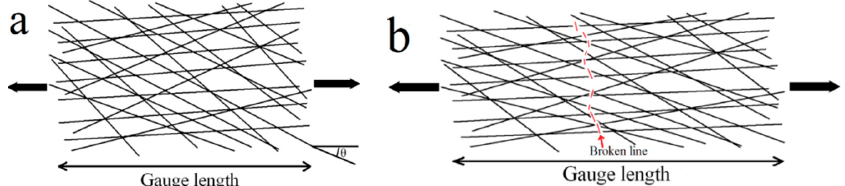
Figure 8. Schematic representations of the micro-model for the fiber network: ( a ) before tensile deformation; ( b ) after tensile break, in which state every single fiber experiences plastic deformation and is elongated, contributing to the accumulation of fracture energy of sintered 316L SSFFs.